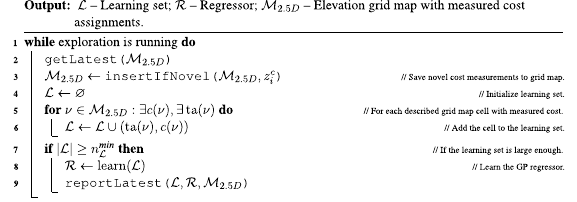
Algorithm 5. Traversal cost model